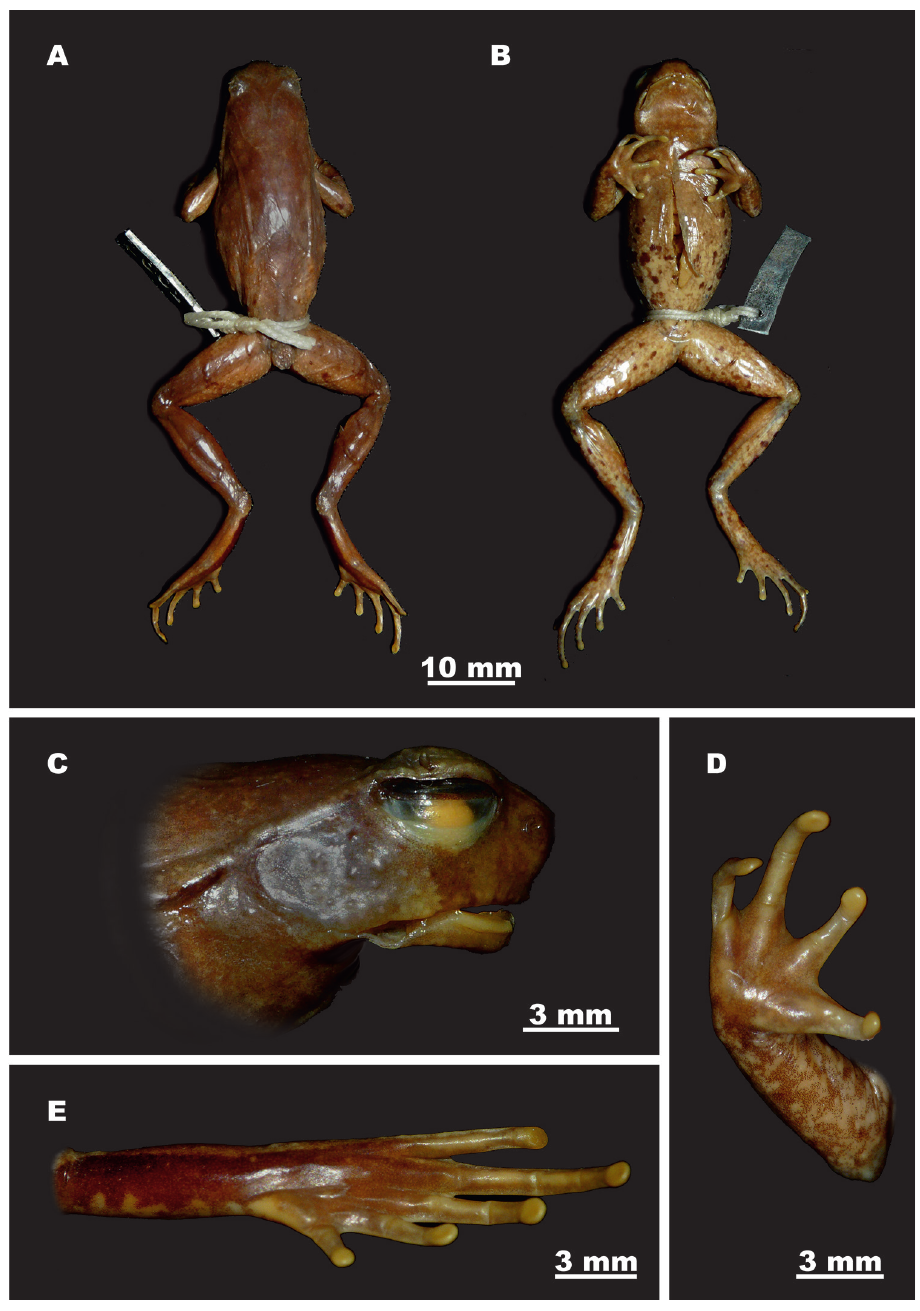
Figure 7. Holotype Ophryophryne gerti (BMNH 1921.4.1.324, male) in preservative: A dorsal view B ventral view C head, lateral view D volar view of the left hand E plantar view of the left foot. Photos by S.